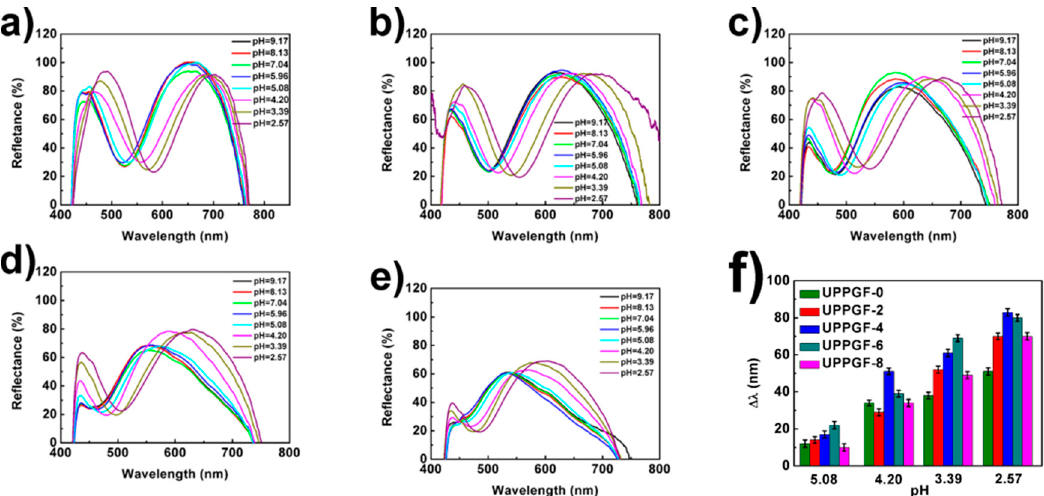
Figure 4. ( a – e ) pH dependence of the reflectance spectra of the UPPGF-x (x = ( a ) 0 min; ( b ) 2 min; ( c ) 4 min; ( d ) 6 min; ( e ) 8 min) sensors after equilibration in pH buffer solution; and ( f ) the corresponding shifts of the reflectance peak of UPPGF-x.